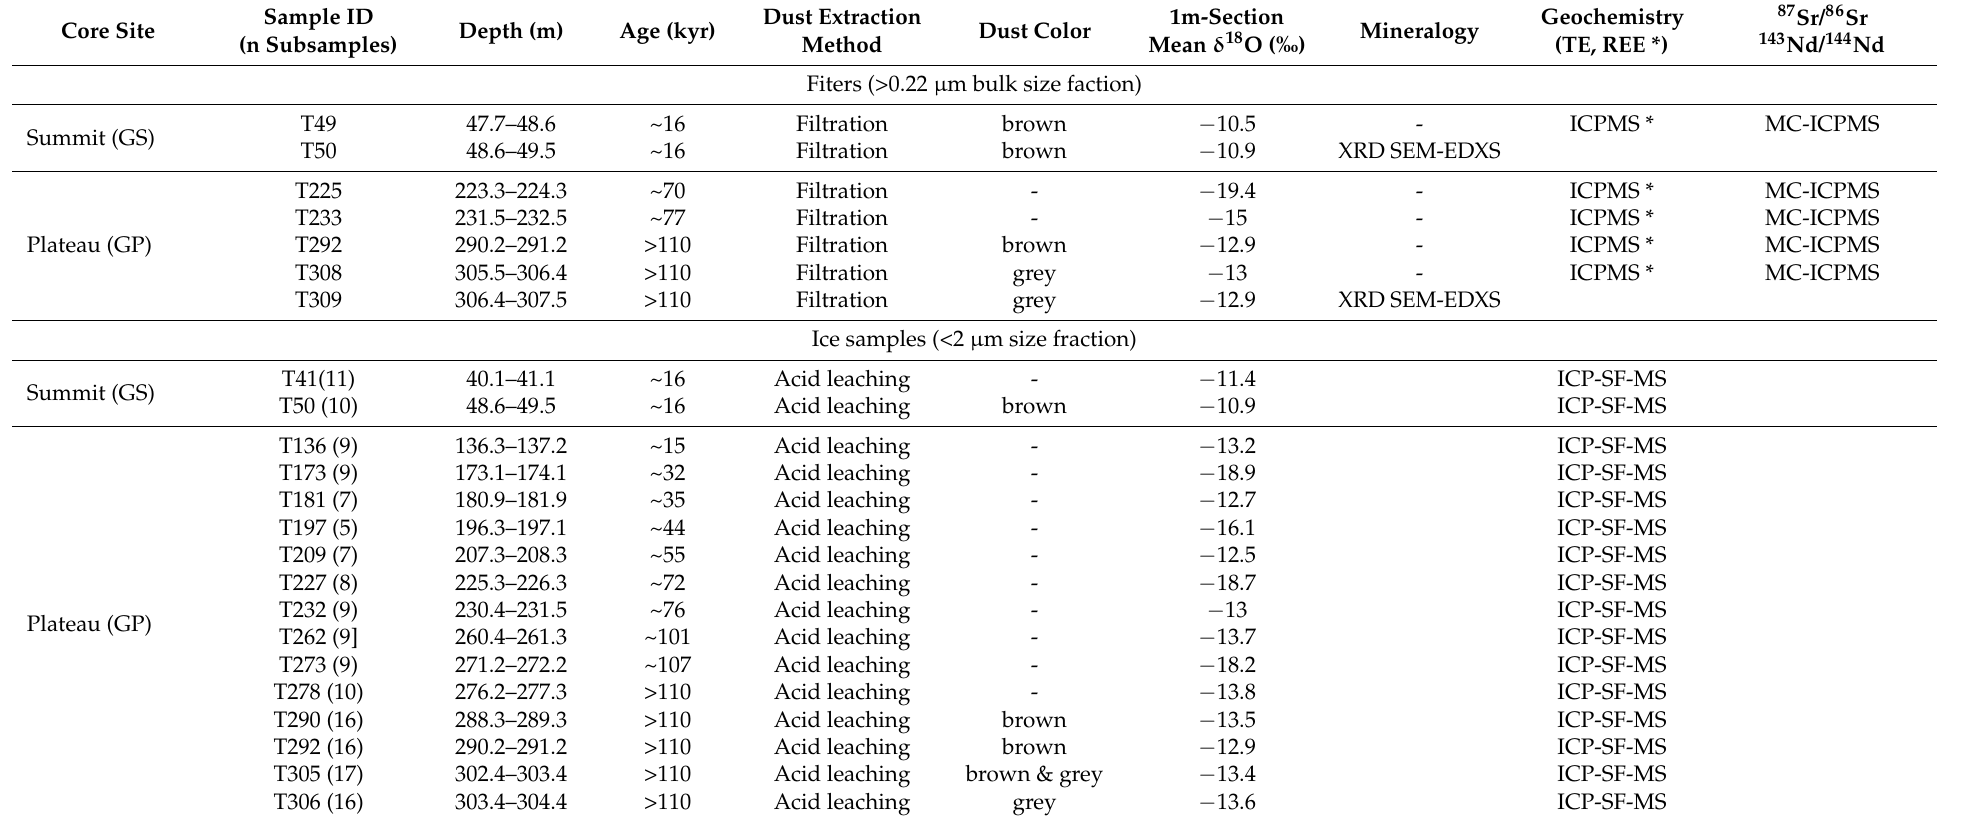
Table 1. Sampling and analytical